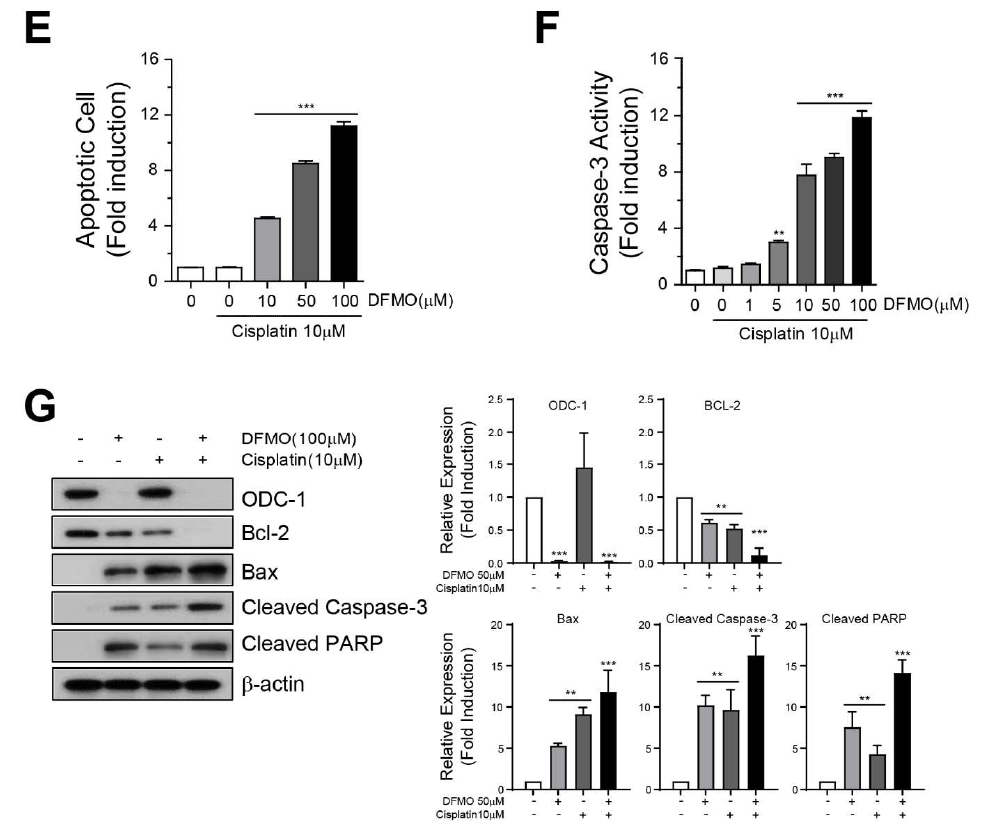
Figure 3. Effect of combination therapy using DFMO and cisplatin on SKOV-3 cell survival and apoptotic cell death. Cell viability was determined of cells treated with ( A ) 10 µ M cisplatin, 100 µ M DFMO, or ( B ) 10 µ M cisplatin/0–100 µ M DFMO for 48 h using the PrestoBlue assay and CellTiter-Glo assay. ( C ) Proliferation was determined in cells treated with ( C ) 10 µ M cisplatin, 100 µ M DFMO, or ( D ) 10 µ M cisplatin/0–100 µ M DFMO for 48 h. ( E ) Flow cytometric analysis of Annexin V-FITC/PI-stained SKOV-3 cells treated with 10 µ M cisplatin/0–100 µ M DFMO for 48 h was performed to determine the apoptotic rates of SKOV-3 cells under various concentrations of DFMO. ( F ) Caspase-3 activity in cisplatin/DFMO-treated SKOV-3 cells was measured using the Luciferase Assay (Caspase- Glo 3/7 Assay system). ( G ) Western blot and quantification analysis for the apoptotic proteins Bcl-2, Bcl-xL, Bax, cleaved caspase-3, and cleaved PARP in cells treated with DFMO. The controls were treated with 0.1% DMSO. Data are expressed as mean ± SD. ** p < 0.01, *** p < 0.001 compared with the